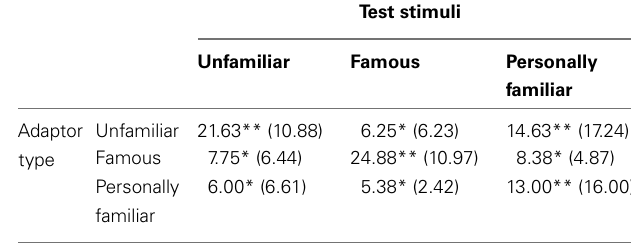
post-adaptation subtracted from the mean number of faces perceived to be distorted at baseline, for each image-type for every adaptor